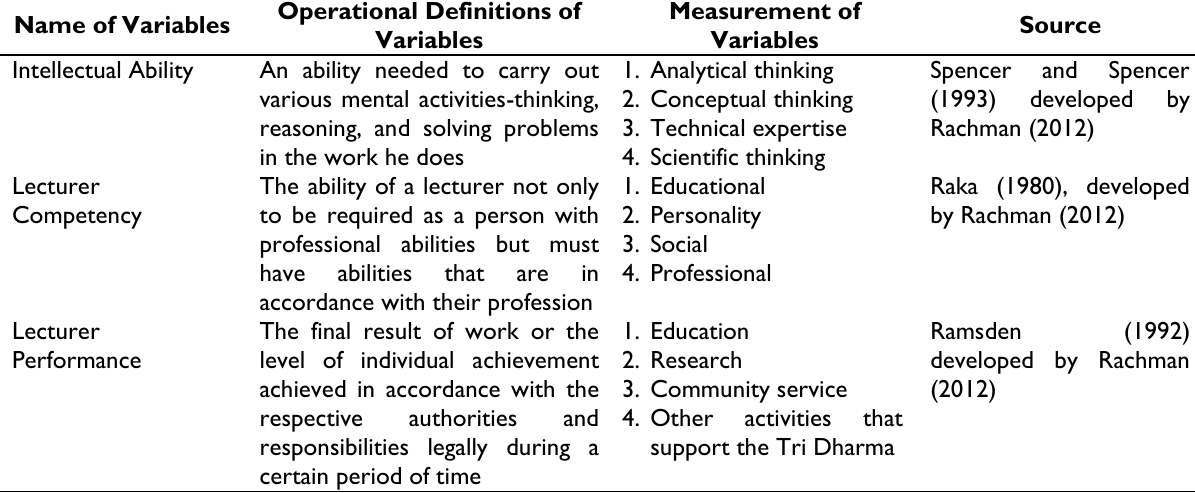
Table 1. Operational Definitions of